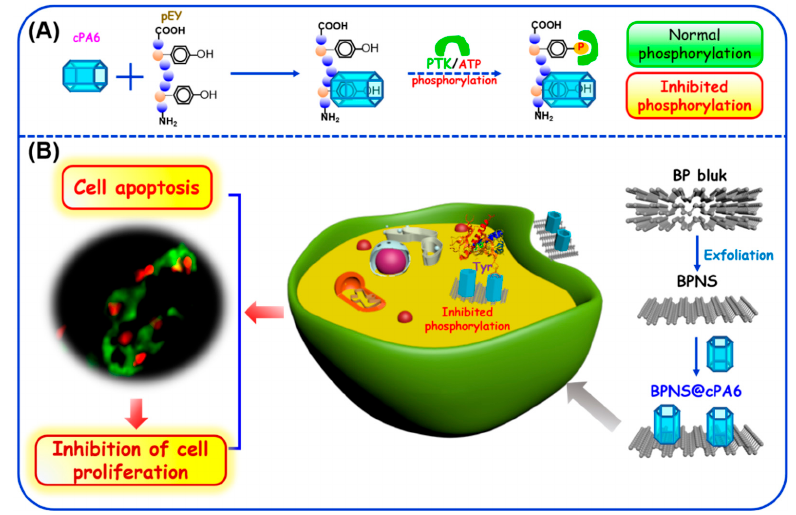
Figure 1. Schematic representation of the proposed mechanism of cationic pillar[6]arene (cPA6) - mediated inhibition of tyrosine (Tyr) phosphorylation. inhibitionoftyrosine(Tyr)phosphorylation. ( A )cPA6inhibitsTyrphosphorylationbyhost–guestrecognition. ( B ) cPA6 induces cell apoptosis by inhibiting Tyr